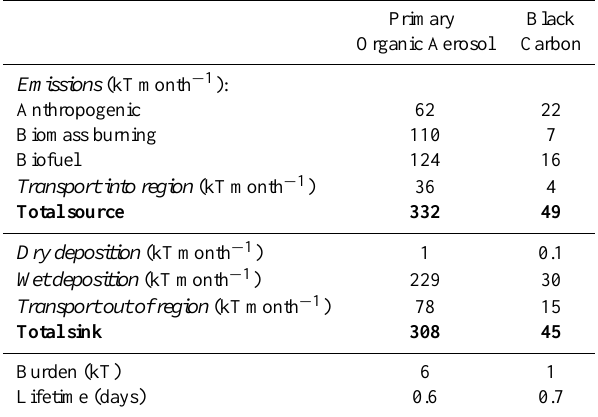
Table 3. GEOS-Chem model budget of primary organic aerosol and black carbon over Borneo, 25 June–25 July, 2008. Primary Black Organic Aerosol